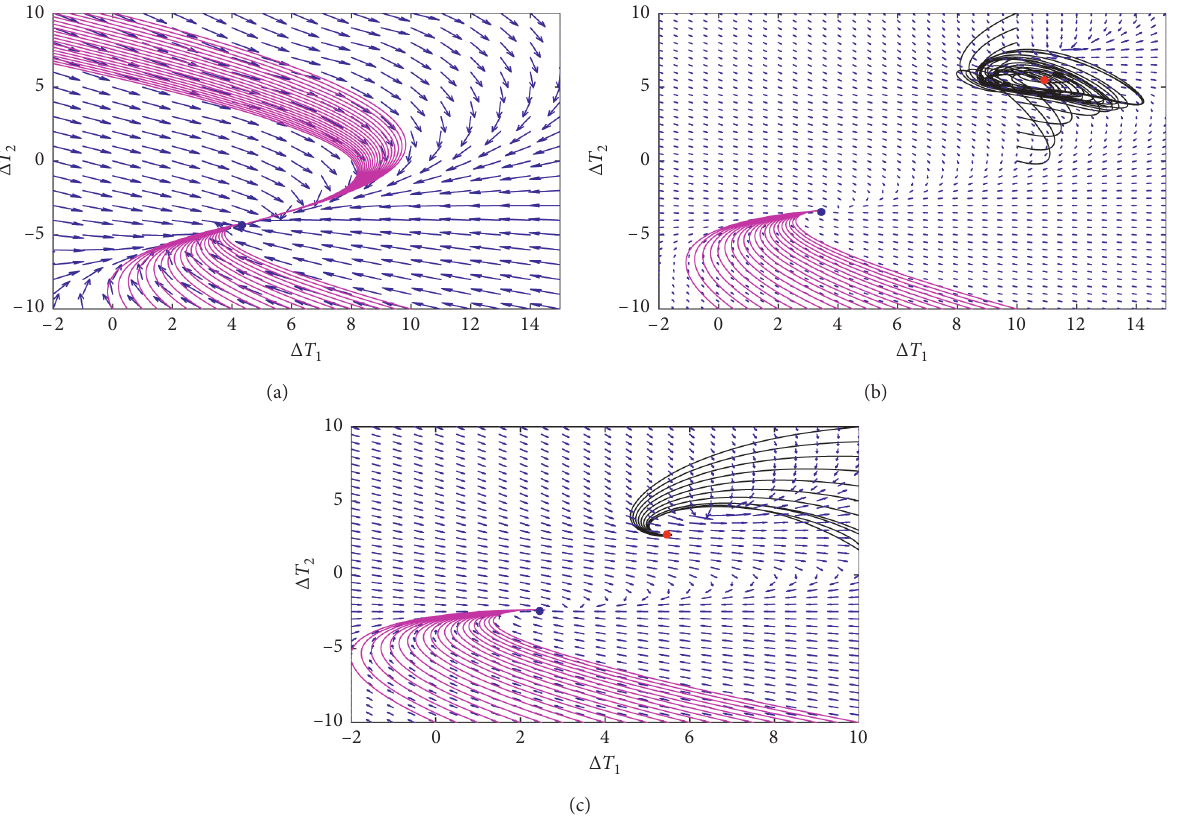
Figure 4: Phase portrait and vector field for scenario 1 ( k < 0). (a) k �− 0.5 and α � 1; (b) k � − 0.5 and α � 3, where the red dot indicates the equilibrium point of realization 1 and the blue dot represents the equilibrium point of realization 2; (c) k � − 0.5 and α � 10, where the red dot indicates the equilibrium point of realization 1 and the blue dot represents the equilibrium point of realization